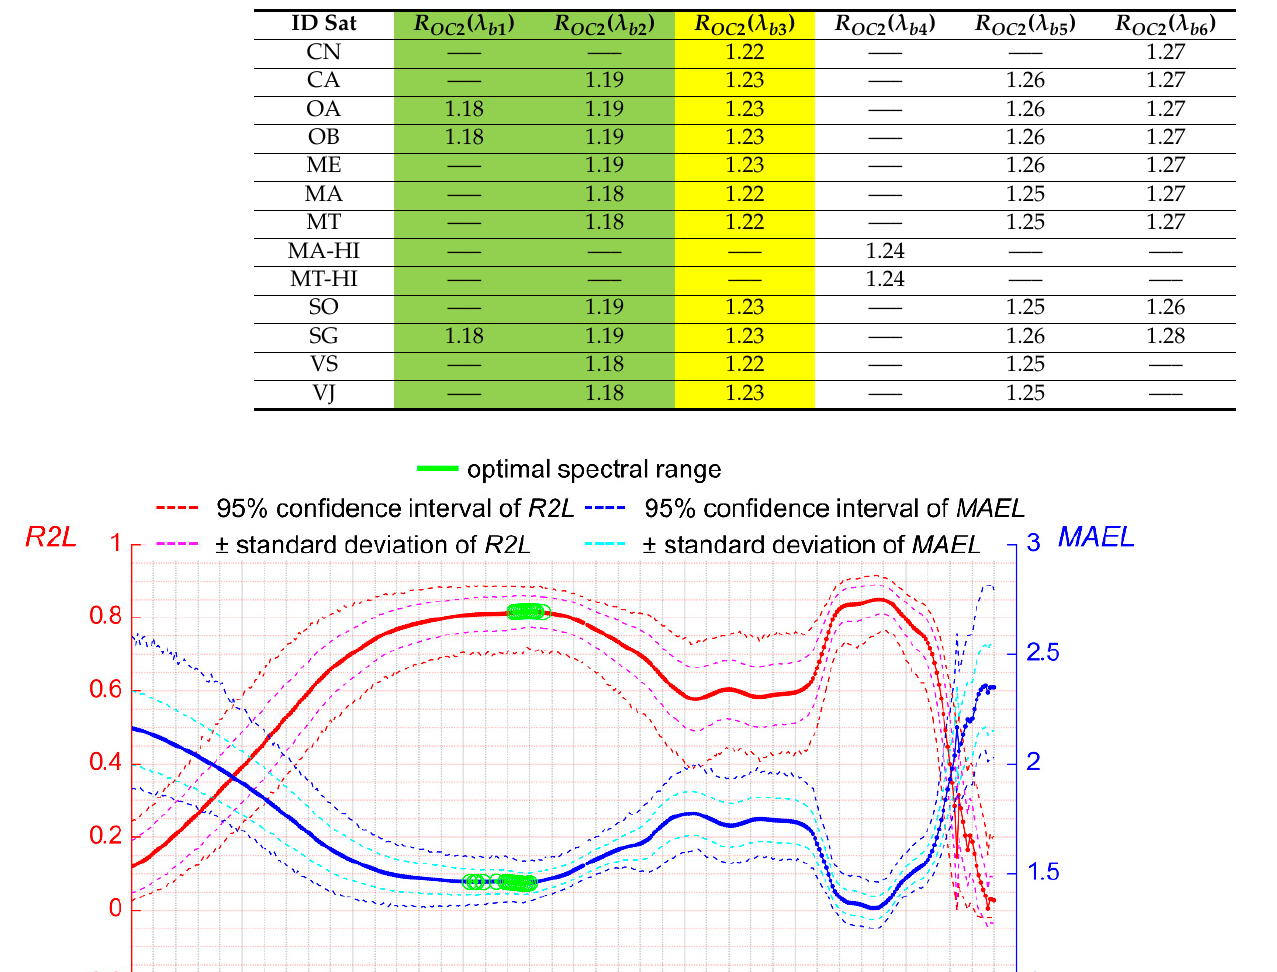
Table 5. MAEL values for comparison between measured in situ CDOM content ( D ins ) and estimated remote sensed CDOM content ( D rs ) calculated using Formula (9) for spectral bands from b1 to b6. Columns with the best results are highlighted in green, and columns with mediocre, but acceptable results are highlighted in yellow.